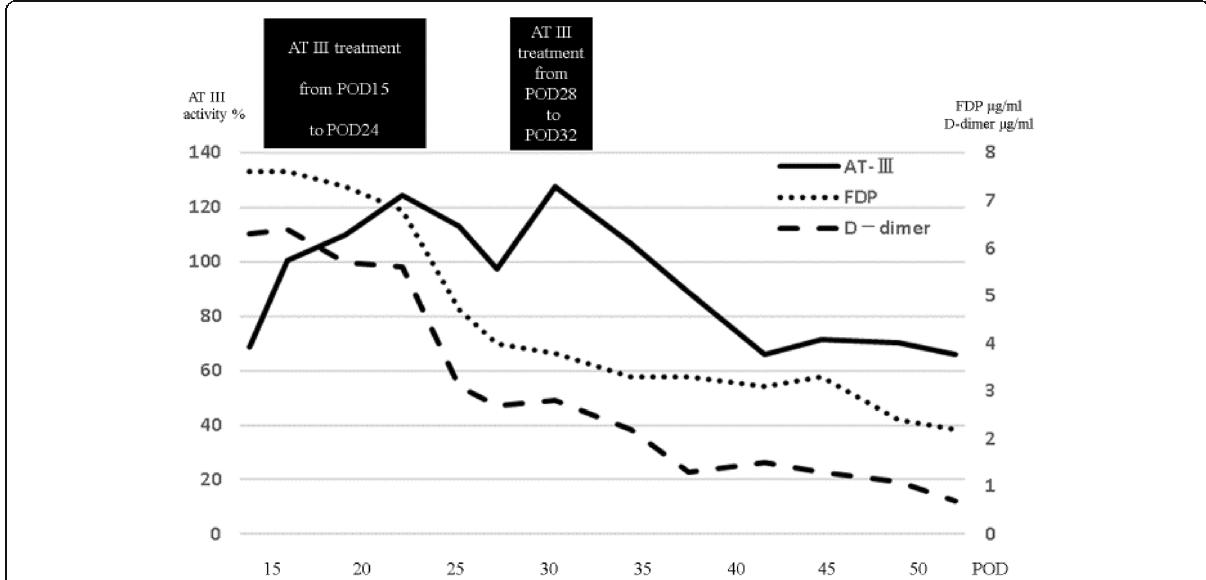
Fig. 3 The chronological changes of AT III, FDP, D-dimer values period of the AT III treatment